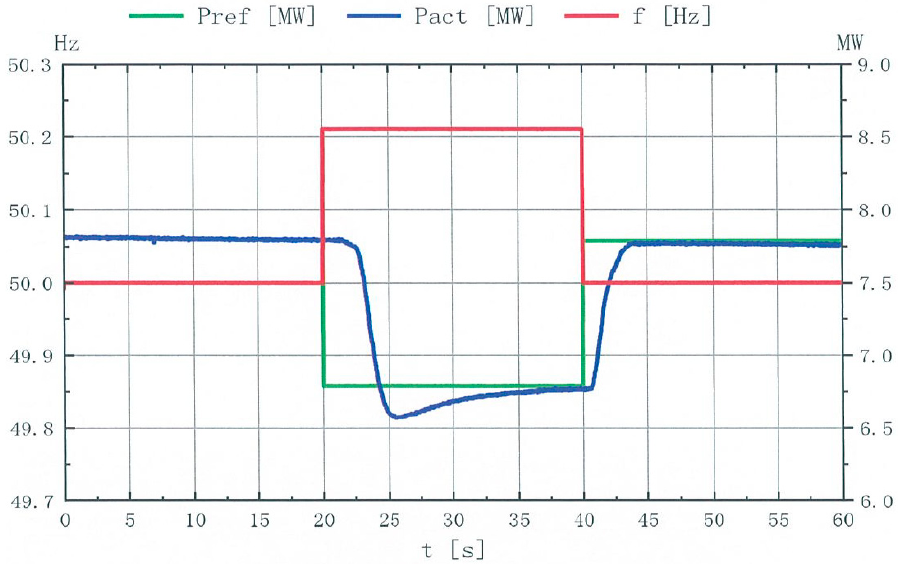
Figure 6. Frequency upward step with successful FFR (average) response waveform.